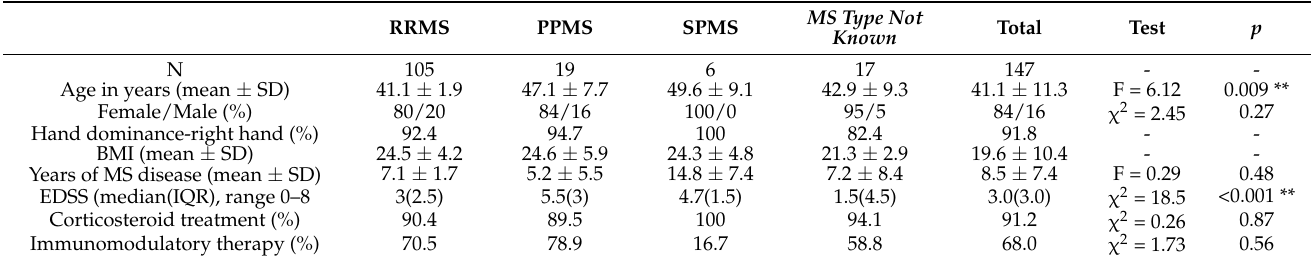
Table 1. Differences in disease-related characteristics, considering MS type.